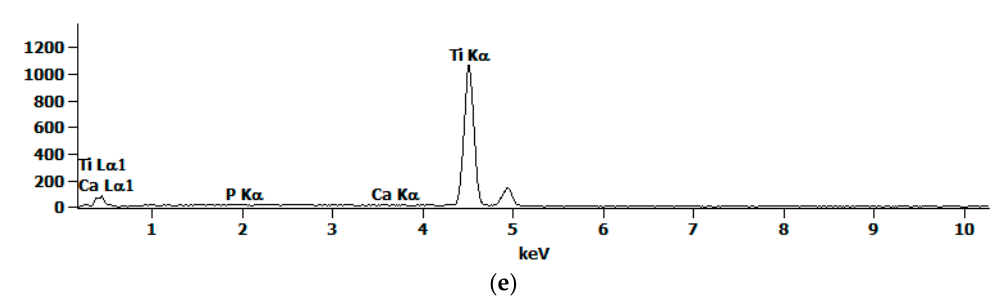
Figure 1. Scanning Electron Microscopy (SEM) pictures ( a – d ) and Energy-dispersive X-ray Spectroscopy (EDS) spectrum ( e ) of the porous coating formed on commercial purity (CP) Titanium Grade 2 after Plasma Electrolytic Oxidation (PEO) treatment at a voltage of 450 V in 10 g Ca(NO 3 ) 2 ·4H 2 O in 1000 mL H 3 PO 4 electrolyte. Magnifications: ( a ) 500×, ( b ) 1000×, ( c ) 5000×, ( d ) 10,000×.